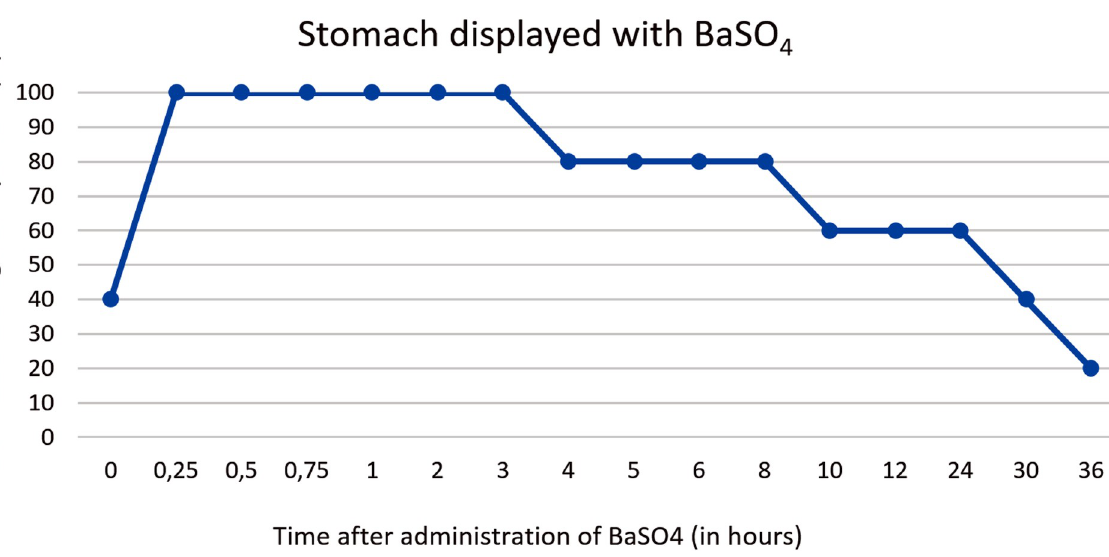
PLOS ONE | https://doi.org/10.1371/journal.pone.0221050 August 22,